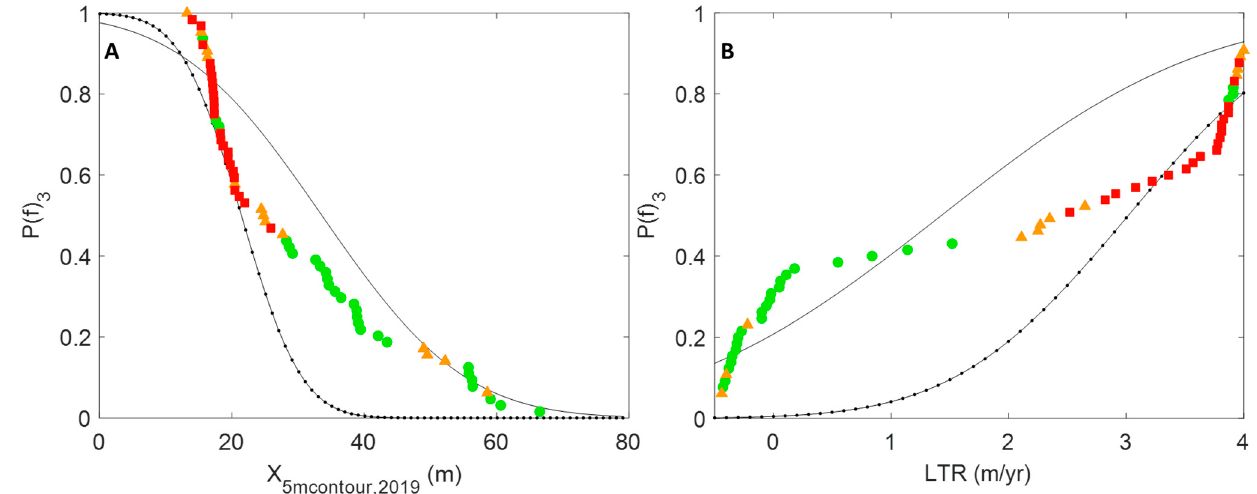
Figure 5. Probability P(f) 3 of marsh being classified as severely eroded (black curve with markers), probability P(f) 3 of marsh being classified as eroded/severely eroded (black curve), with empirical data showing shoreline classification as healthy (green circles), eroded (orange triangles), or severely eroded (red squares) as a function of ( A ) distance (m) to 2019 5 m contour X 5mcontour,2019 ; ( B ) long-term erosion rate LTR (m/year).